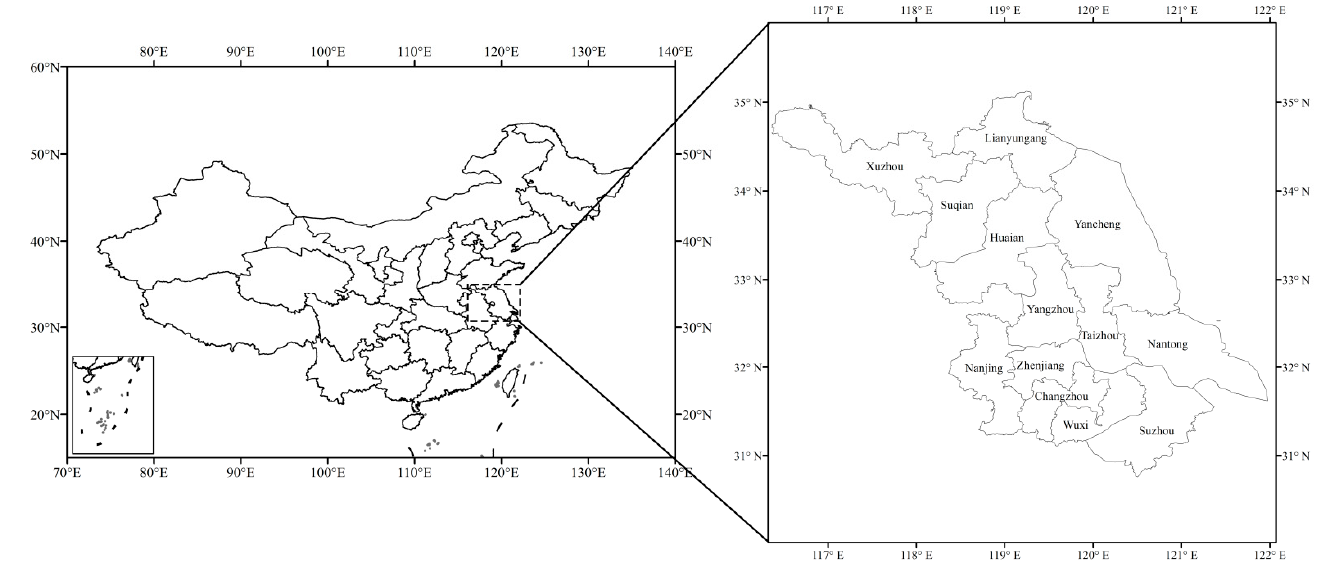
Figure 1. Administrative division of the study area.